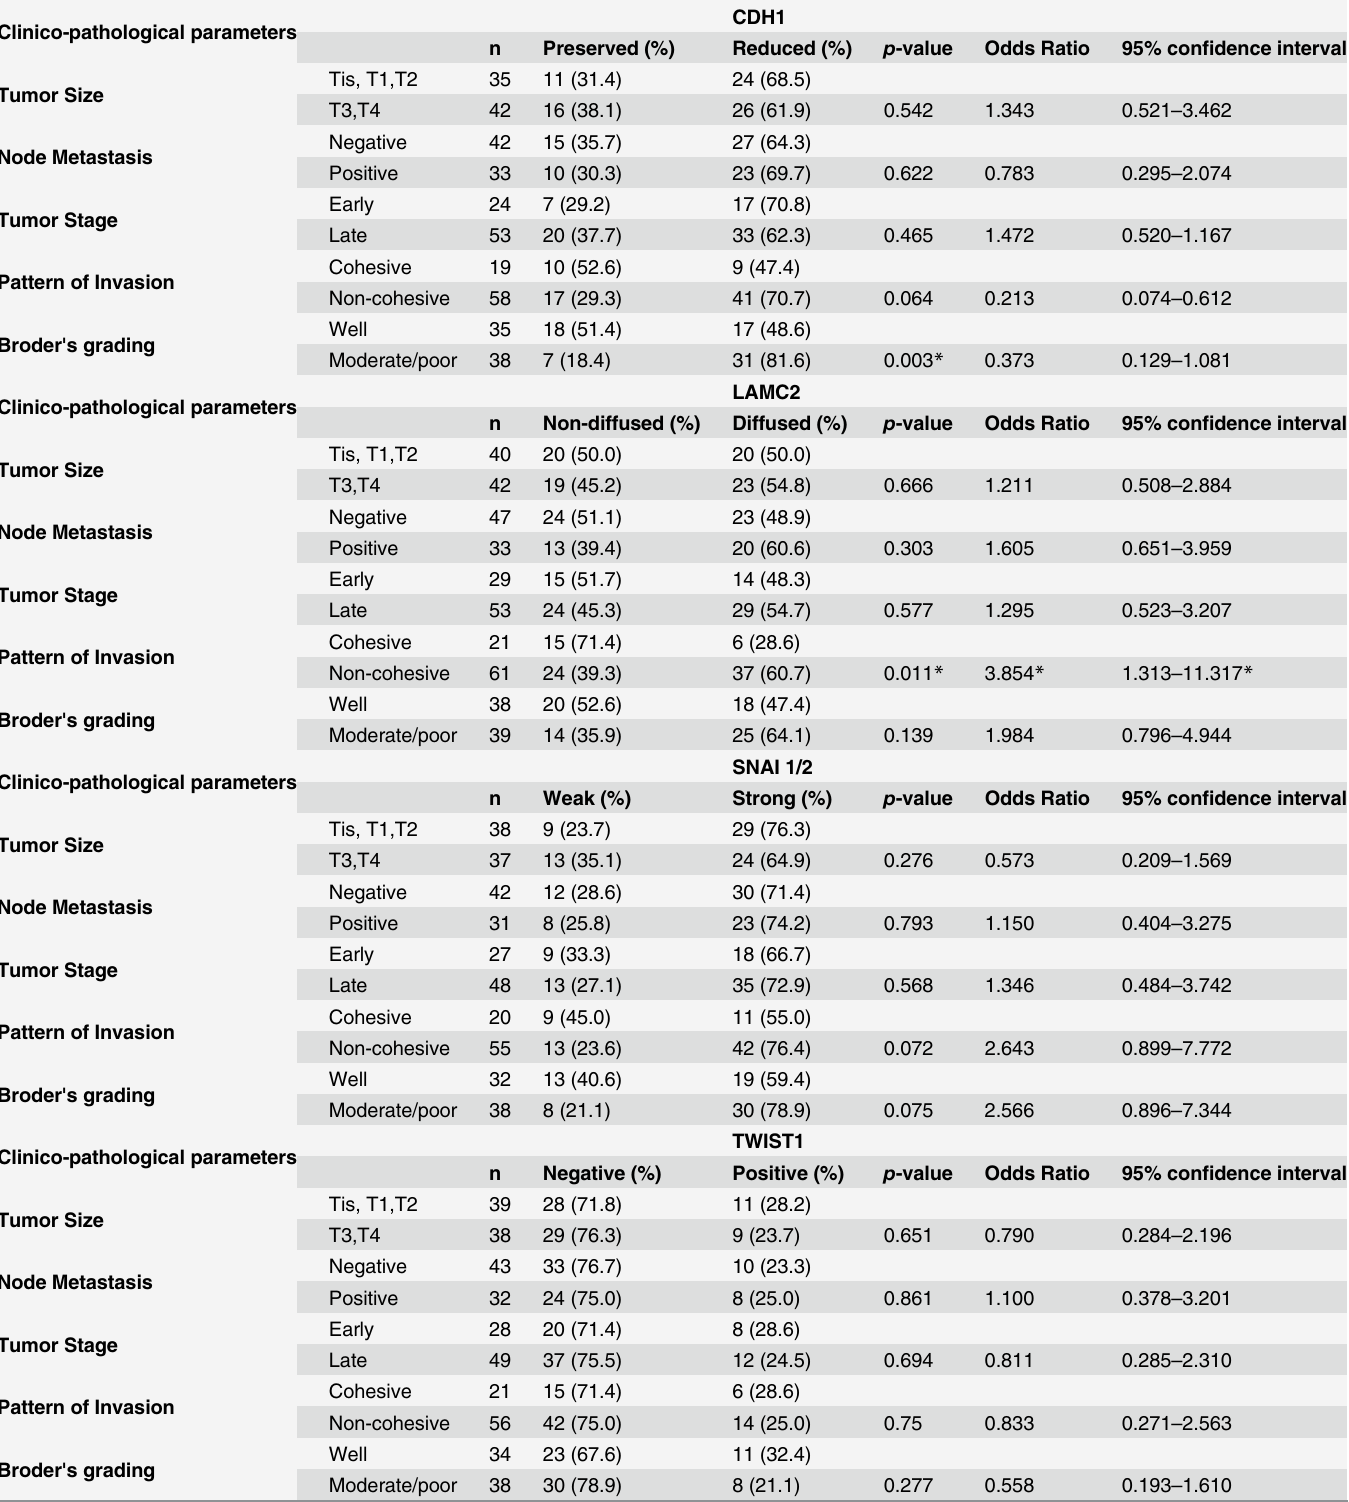
Table 3. Association between expression of EMT-related proteins with clinico-pathological